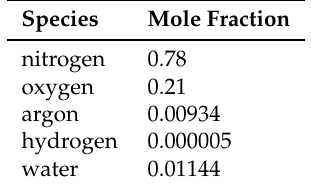
Table 1. Input values for computation of air species with the chemical equilibrium with applications